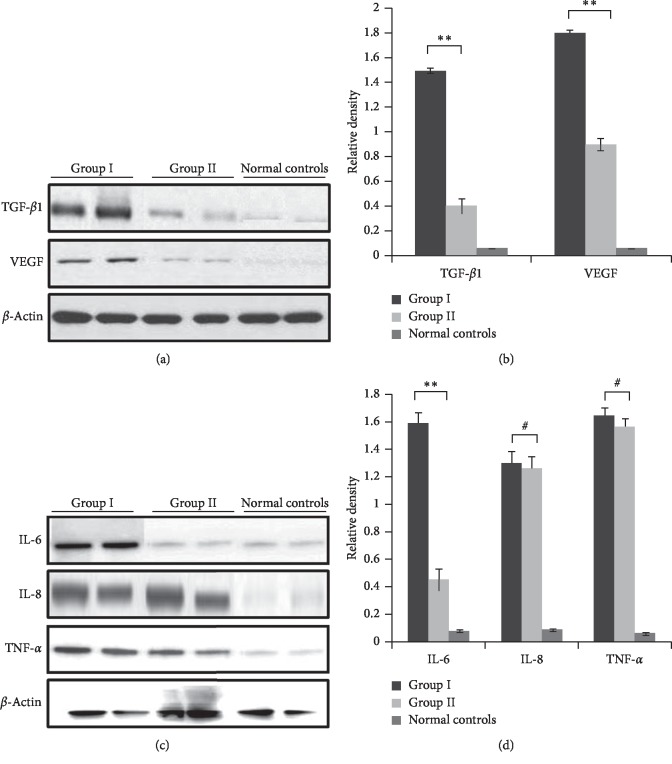
MMC decreases the expression of pro-inflammatory cytokines in pterygium tissues. (a, b) Expression of TGF-β1 and VEGF proteins in pterygium tissues from group I and group II patients was determined via western blotting analysis. (a) Data are also shown as representative of three independent experiments (b) ∗∗P < 0.01. (c, d) Expression of inflammatory factors such as IL-6, IL-8, and TNF-α was evaluated via western blotting analysis. Data are shown as representatives (c) and also are shown as representative of three independent experiments (d) ∗∗P < 0.01 and #P > 0.05. Normal corneal tissues were used as controls.